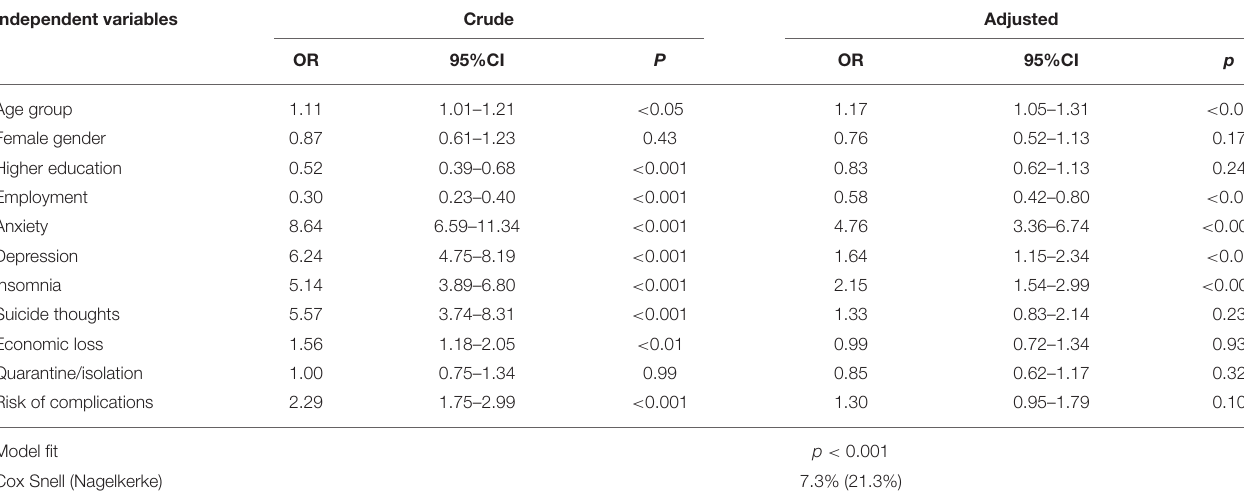
TABLE 4 | Associations with use of sedatives. Independent variables